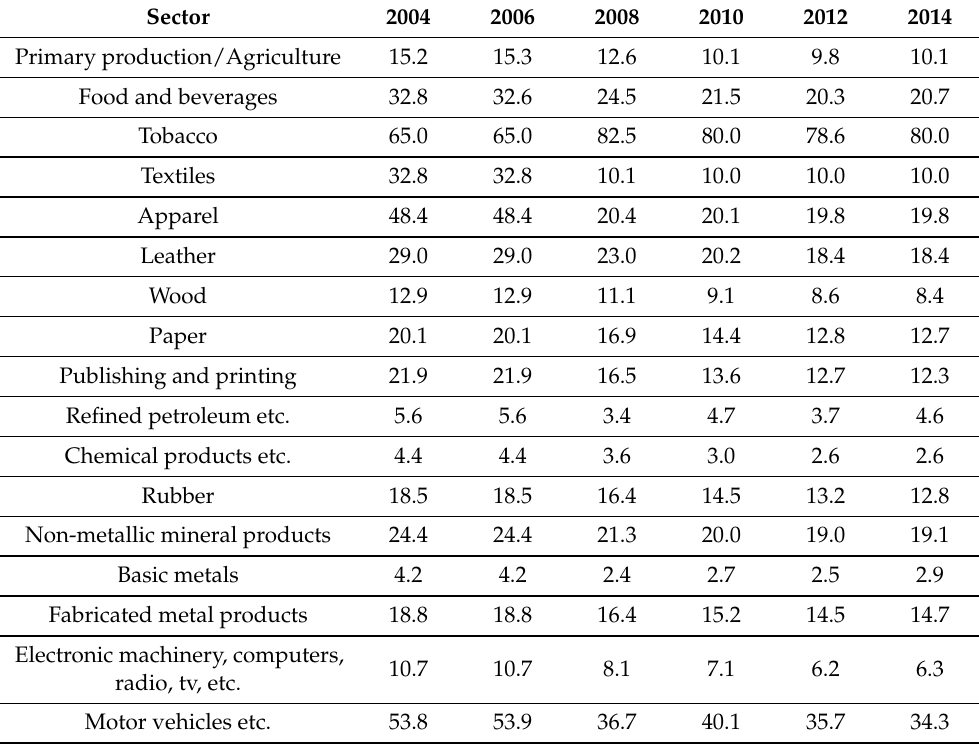
Table 12. Vietnam’s Average Tariff Rates by Manufacturing Industry from 2004 to 2014